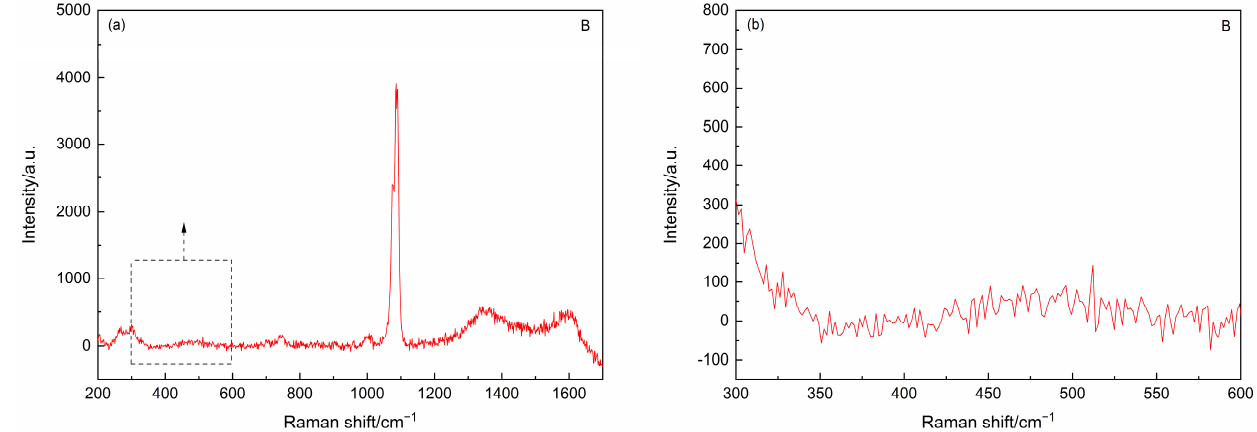
Figure 3. ( a ) Raman spectrum of the point B in Figure 1 after subtracting background. ( b ) Inset of Raman spectrum in ( a ) in the range of 300–600 cm − 1 .